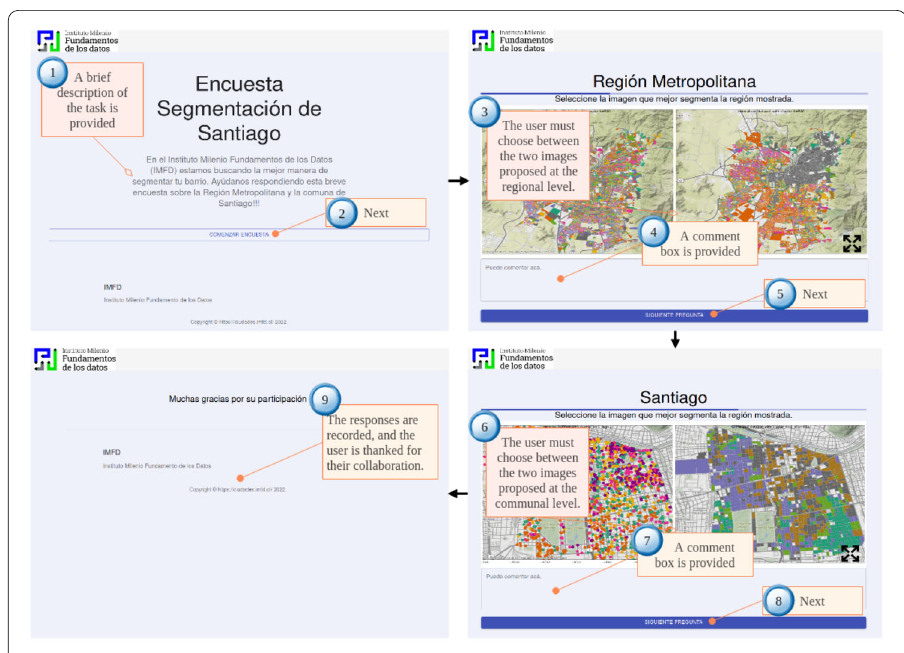
Figure 1 The web tool developed to capture the respondents’ data. The task is to decide which of the two displayed images best segments the indicated area. Users are asked to solve this task both at the regional level and at the commune level. In the example, the user must decide at the global level and then at the communal level for